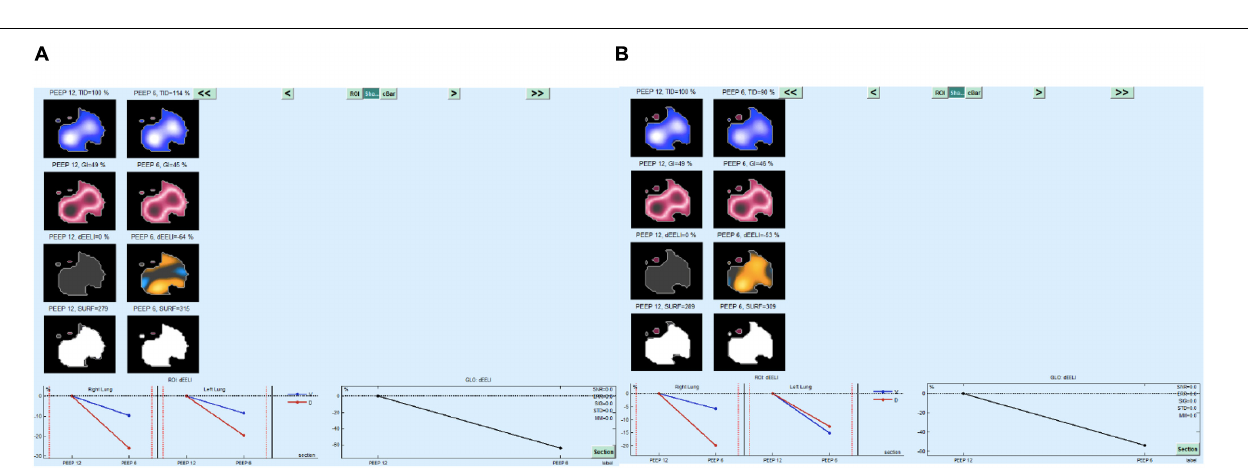
FIGURE 4 | EITdiag MatLAb Analysis of the decremental CPAP trial in a patient who survived, (A) supine, (B) prone. Note the (cid:49) EELI% > 50 in both body positions.